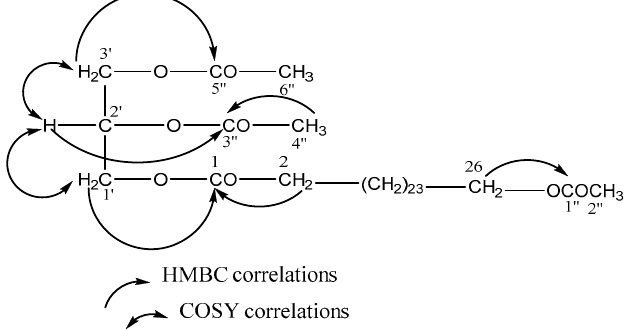
Figure 4. COSY and HMBC correlations for Cordicerol A.